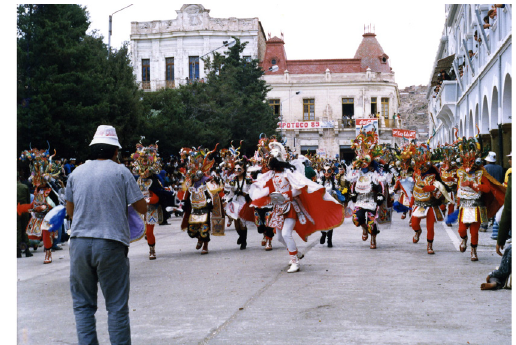
Figure 6. Demon’s festival-I in Bolivia. Figure 3. 16 th ISVHECRI-2010, Batavia.